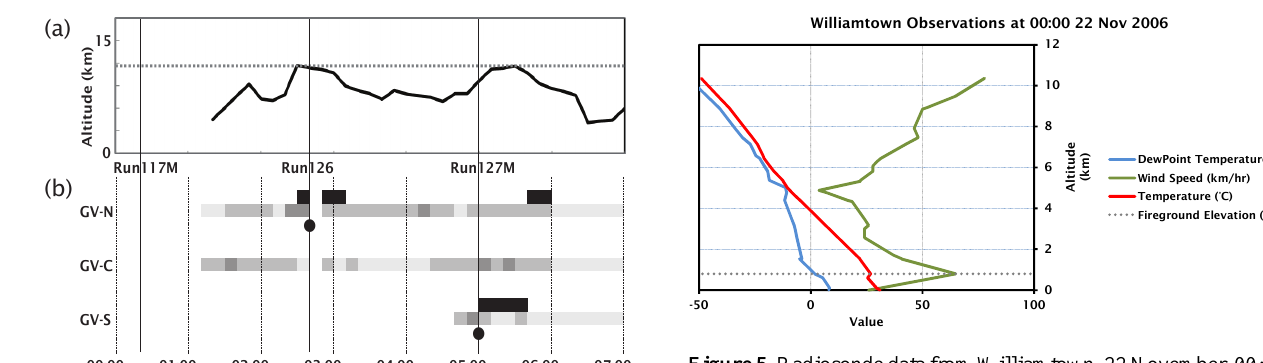
Figure 5. Radiosonde data from Williamtown, 22 November, 00:00. The dotted line indicates the elevation of the GVN fire